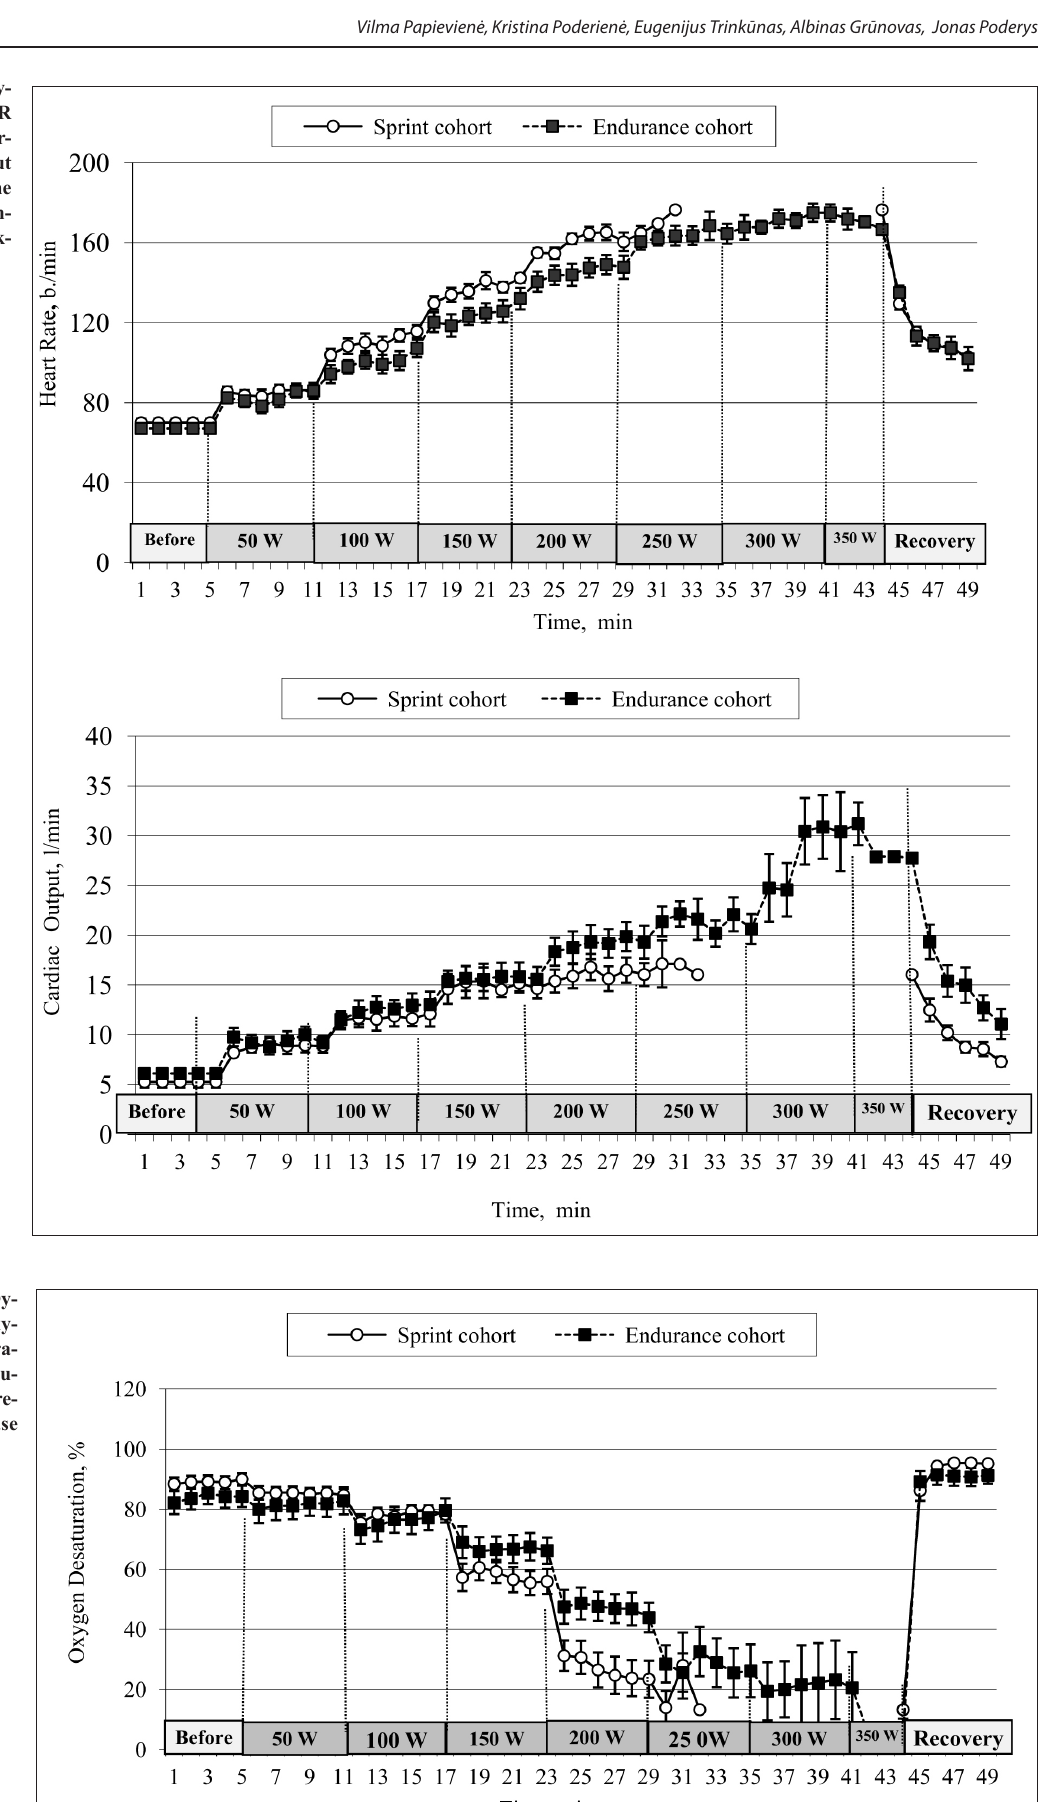
Figure 1. Dy - namics of HR (A) and car - diac output (B) during the incremental in - crease in work- load